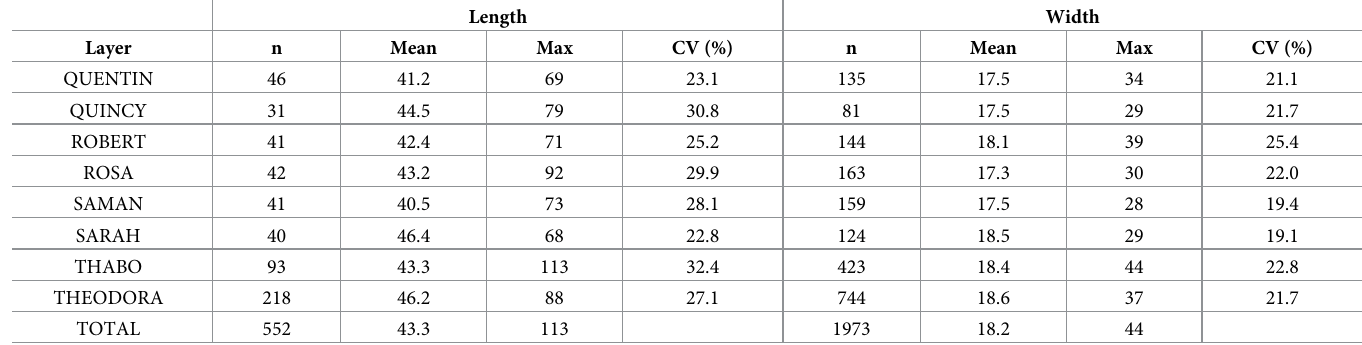
Table 5. Distribution of blade length and width (in mm) by layer for the Sibudu HP.